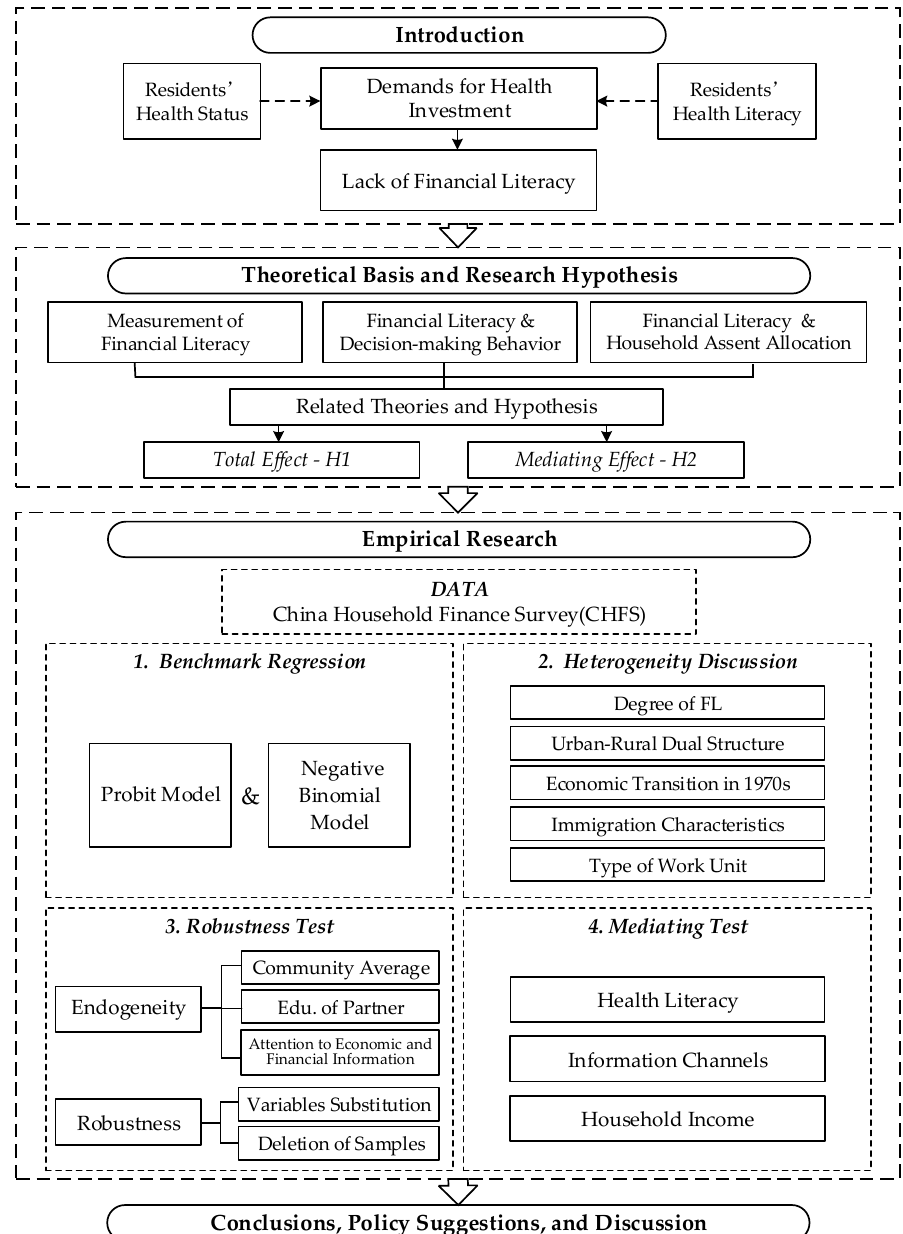
Figure 1. Outline of the research